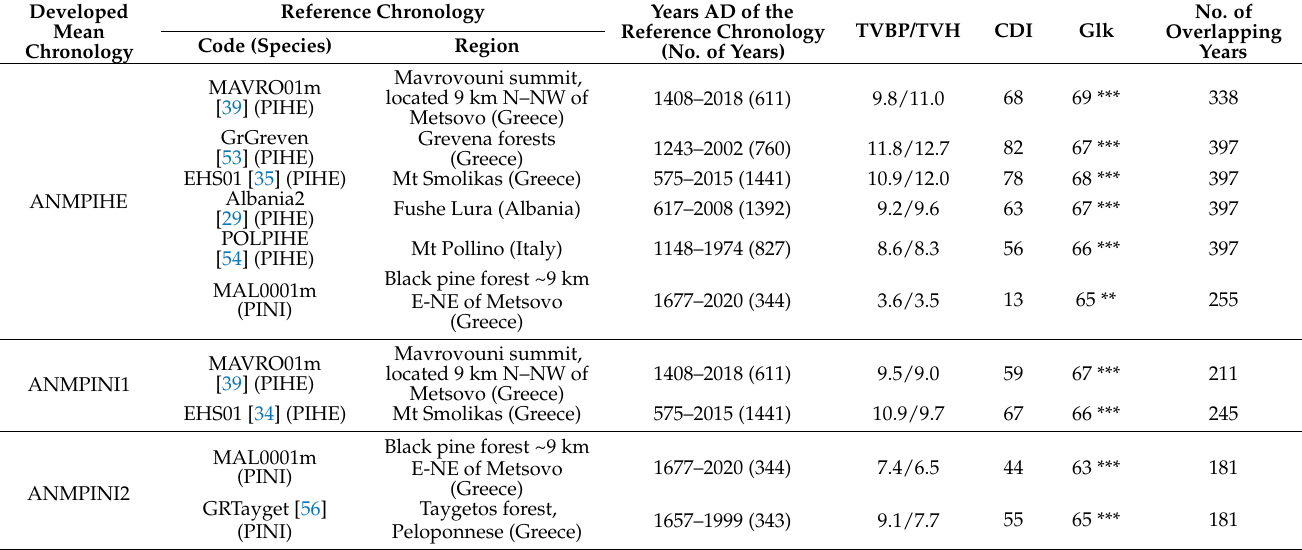
Table 4. Cross-dating results of the three developed pine chronologies (PIHE for Pinus heldreichii and PINI for Pinus nigra ) against the reference chronologies providing the best results. t-value Baillie-Pilcher (TVBP) and t-value Hollstein (TVH) are t-values sensitive to extreme values, such as marker years. CDI = cross-dating index; Glk = Gleichlaeufigkeit, a measure of how well the growth of two trees corresponds to each other in an overlapping set of years.